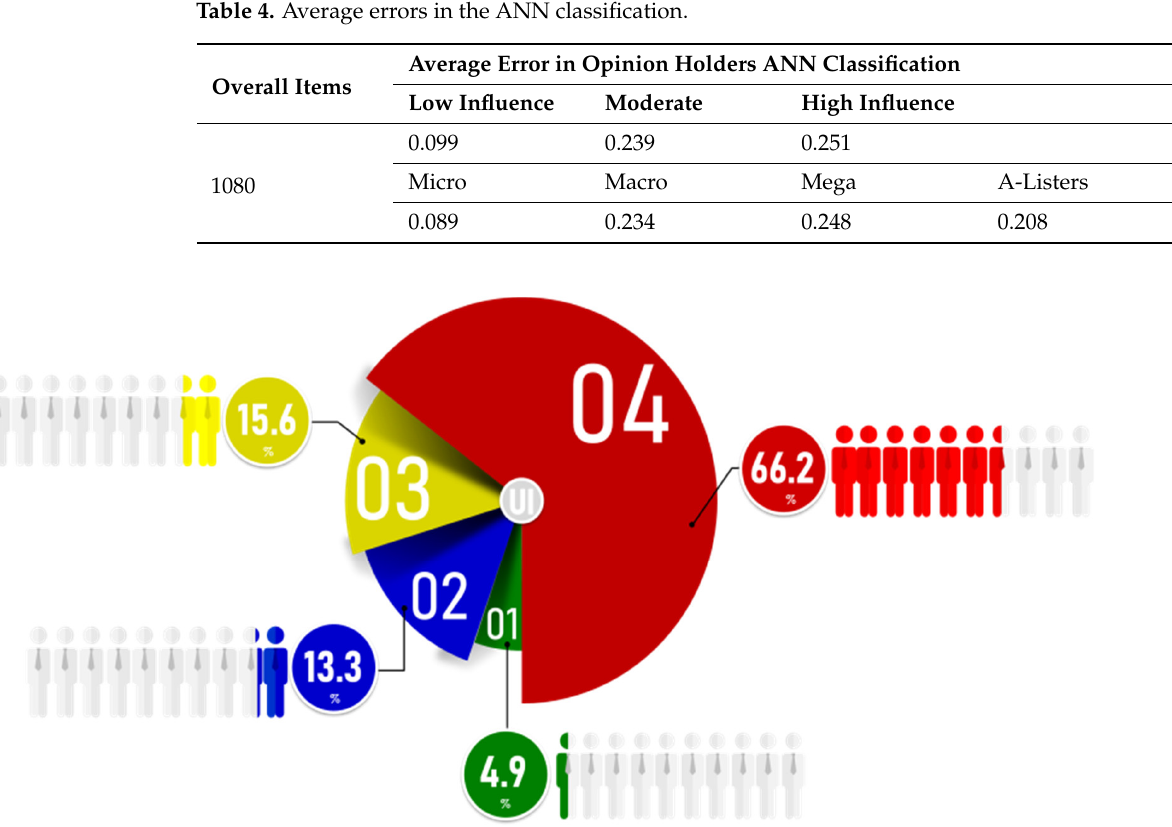
Table 4. Average errors in the ANN classification.